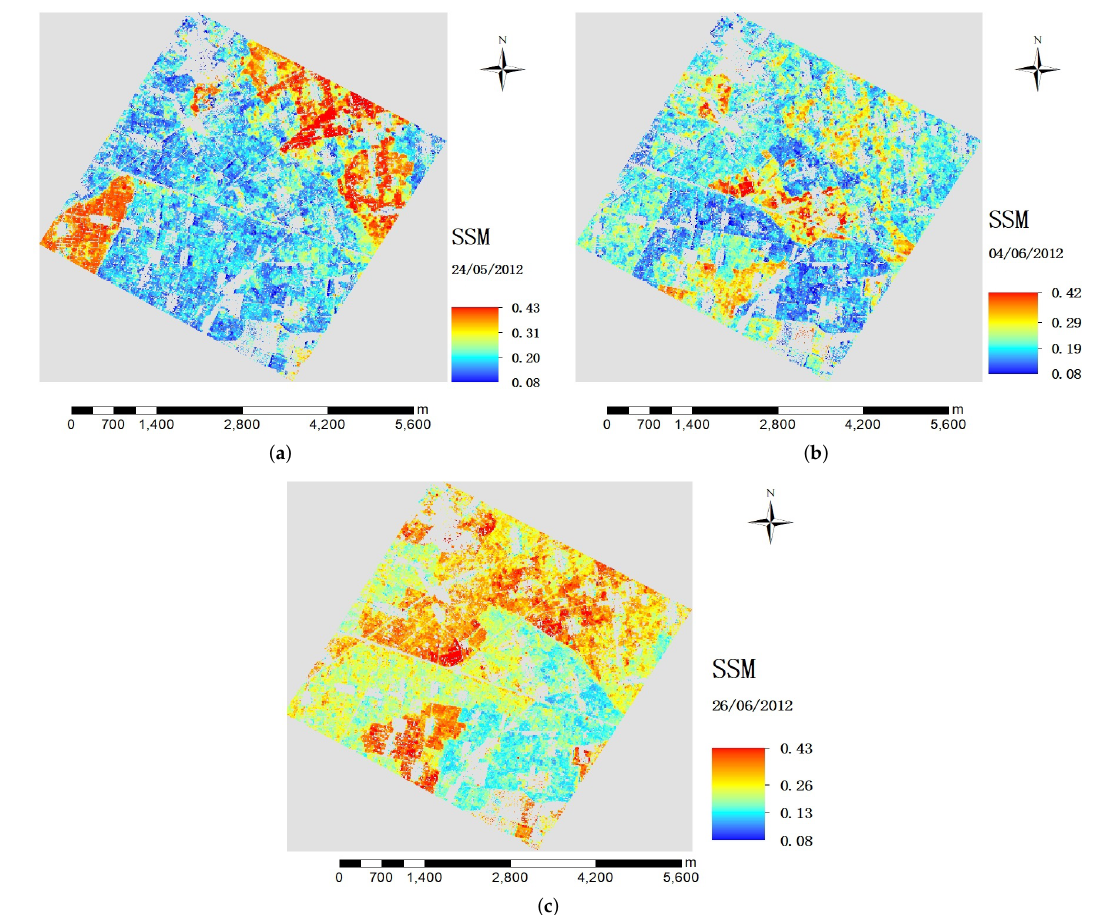
Figure 8. SSM map with the inversion configuration of VV polarization backscattering coefficient and NDVI. ( a ) Emergence stage; ( b ) Trefoil stage; ( c ) Jointing